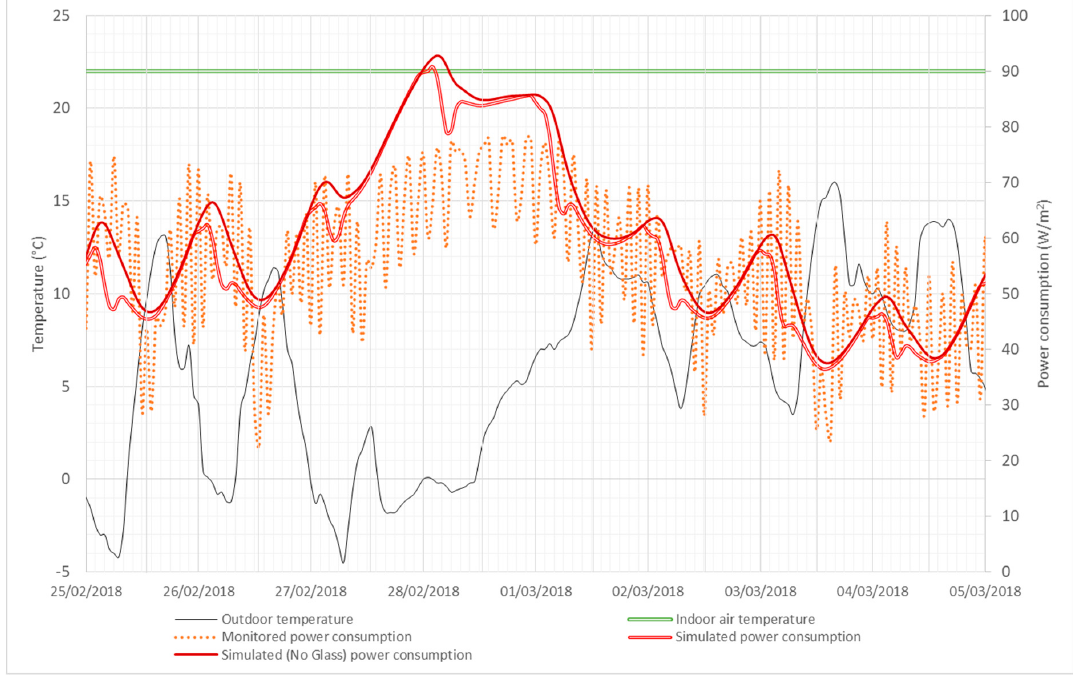
Figure 11. Power consumption of the heater, both simulated and monitored, during the indoor controlled temperature scenario. controlled temperature